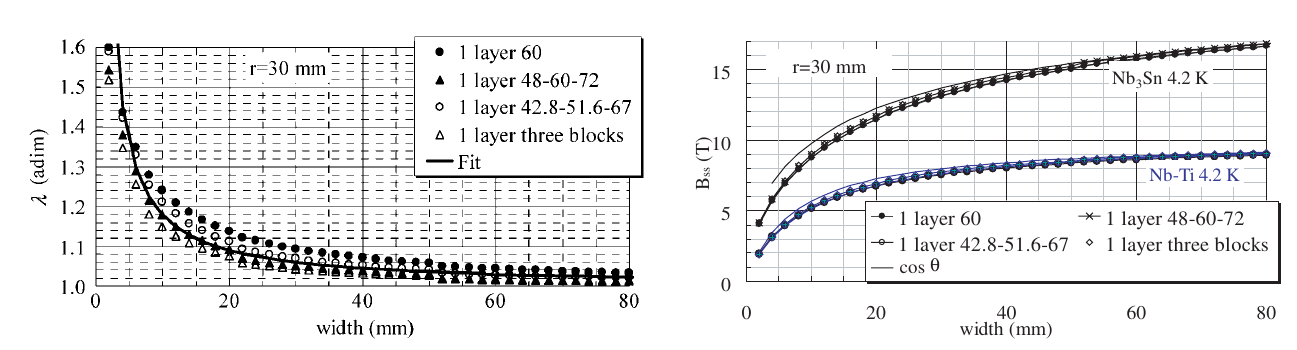
FIG. 6. (Color) Numerical evaluation of the short sample field versus sector width for different sector layouts, aperture radius of 30